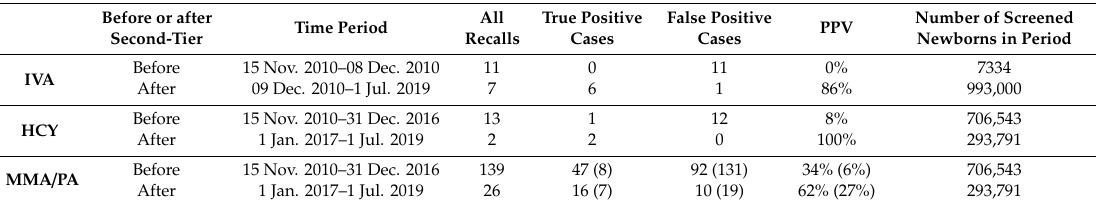
Table 2. Impact of second-tier analysis on false positive cases and PPV values. Babies with confirmed B12 deficiency are included. Within parenthesis are the numbers when babies with vitamin B12 deficiency are counted as false